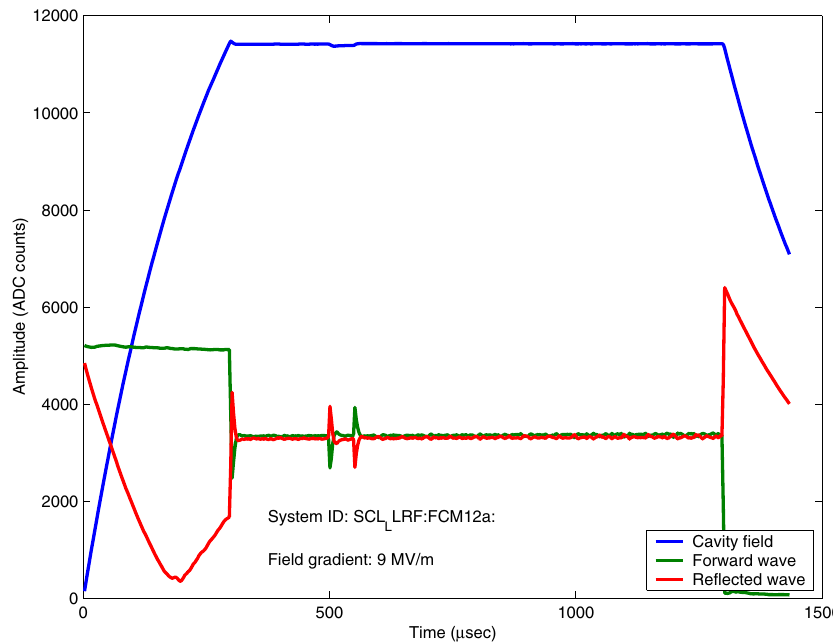
FIG. 6. (Color) A full view of the FCM transient response to a 20% step in feed forward input, measured on superconducting cavity SCL-12a.